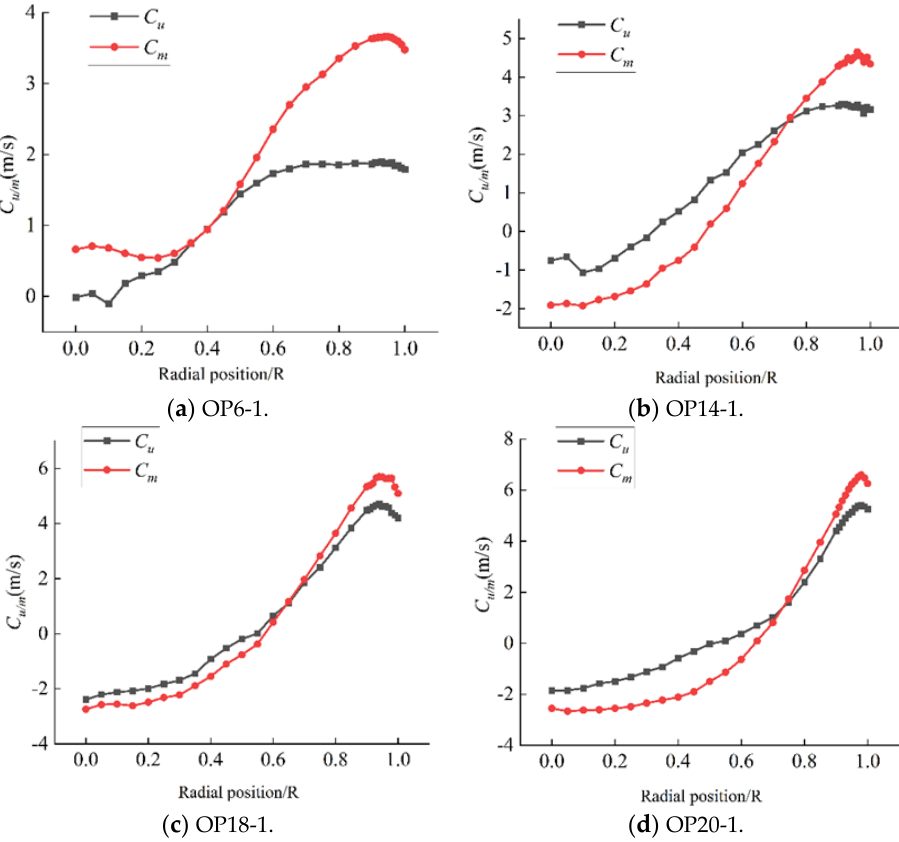
Figure 7. Average tangential velocity and axial velocity in turbine